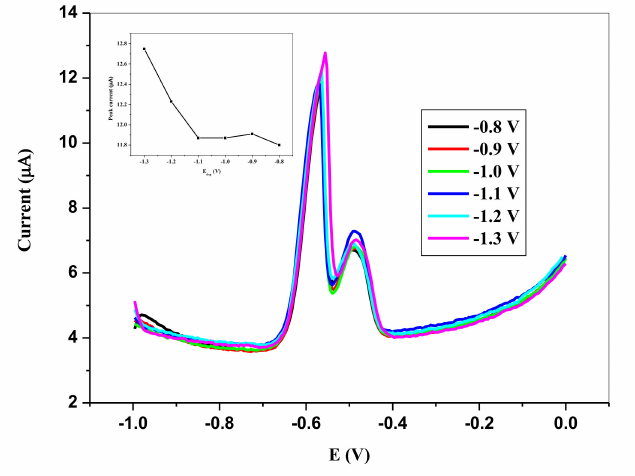
Figure 12. SWVs showing impact of deposition potential on the stripping peak current of 6.0 × 10 − 5 M Pb 2+ in 0.1 M HCl electrolyte on SPCE/OPE/BIONPs/PANI, − 800 mV to − 1300 mV deposition potential, 180 s deposition time, (Potential vs.